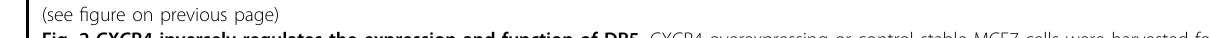
Fig. 2 CXCR4 inversely regulates the expression and function of DR5. CXCR4 overexpressing or control stable MCF7 cells were harvested for protein extraction and analyzed for the expression of apoptotic genes by utilizing proteome pro fi ler apoptosis array of individual western blot analysis. A Chemiluminescent image of the expression of 35 apoptosis-related genes with positive and negative controls in duplicates for control and CXCR4 overexpressed cells was shown (left panel). The enlarged images of selected apoptotic protein (DR5) found to be markedly altered in the proteome pro fi ler array (middle-upper) and spot coordinates (middle-lower) were shown. B Heatmaps depicting differentially regulated proteins in CXCR4 overexpressing and control stable MCF7 cells. C Immunoblot analysis of DR5 protein in CXCR4 overexpressing or control MCF7 cells; β -Actin was used as an internal protein loading control. D CXCR4 overexpression and control MCF7 cells were either stained with PE-conjugated anti-human DR5 or PE tagged isotype (IgG) control antibodies, and cell surface expression of DR5 was analyzed by histogram overlays using FACS. E Immunoblot analysis of DR5 protein in CXCR4 knockdown or control HT-29 cells; β -Actin was used as an internal protein loading control. F CXCR4 knockdown and control HT-29 stable cells were stained either with PE-conjugated anti-human DR5 or PE tagged isotype control antibodies. Cell surface expression of CXCR4 was analyzed by histogram overlays using FACS. G Chili tagged CXCR4 knockdown and control HT-29 stable cells were mixed equally and subjected to FACS analysis at Day 0 and 3 days after recombinant human TRAIL (50 ng/mL) treatment. H CXCR4 knockdown and control stable cells were treated with different concentrations of TRAIL (6.25, 12.5, 25, 50, 100 ng/mL) for 48 h, and cytotoxicity was measured by SRB assay. Percent cell viability was tabulated. Columns, an average of triplicate readings of samples; error bars ± S.D. ** p < 0.01; #, p < 0.05, compared to TRAIL-treated control cells. I Control and CXCR4 knockdown HT29 cells were treated with Rh-TRAIL for 24 h and stained with FITC conjugated Annexin-V. Histogram overlays show the Annexin-V positive cells. J Immunoblot analysis of cleaved PARP and Caspase-8 in 24 h post vehicle or TRAIL-treated (10, 20, and 40 ng/mL) control and CXCR4 knockdown HT-29 cell lysates; β -Actin was used as the protein loading control. Western Blot densitometric quanti fi cation numbers are shown above the loading control blot of all immunoblot